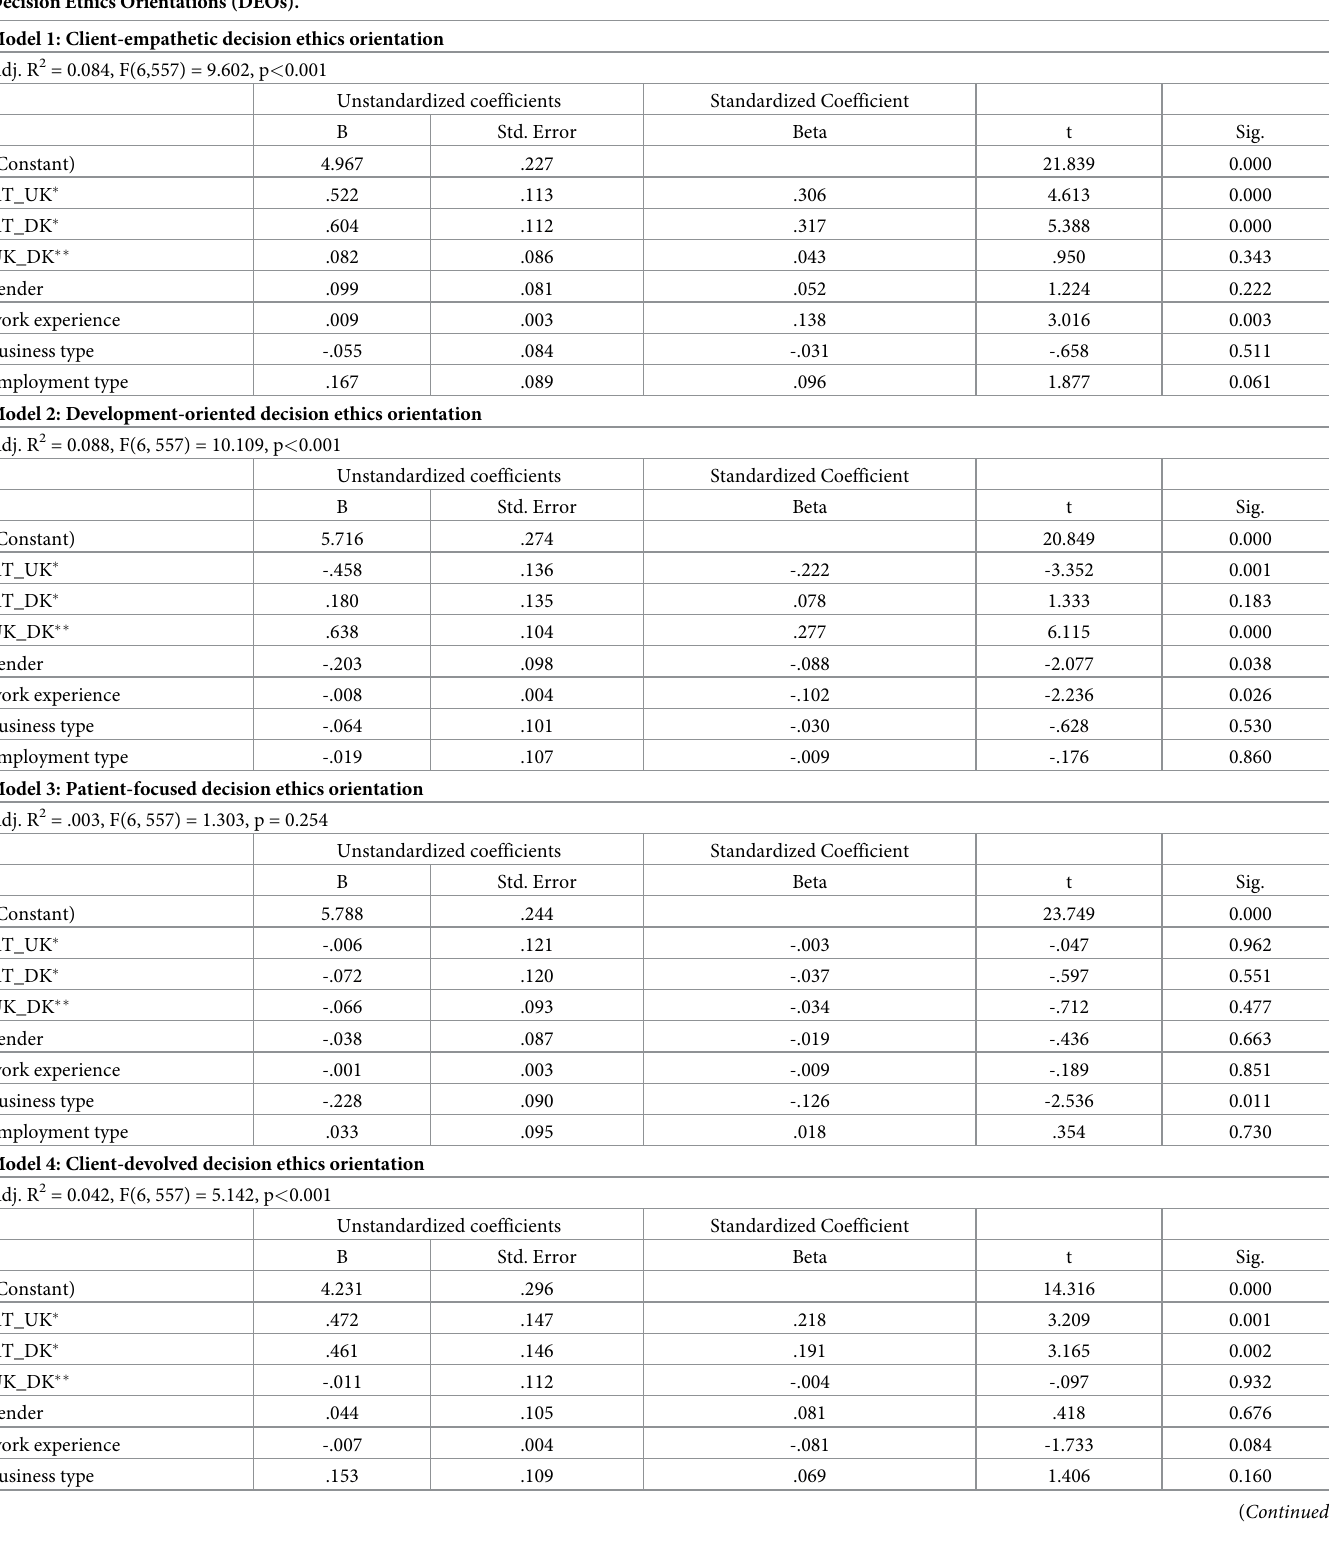
Table 5. Multivariate regression analyses of predictors (including socio-demographic (with work experience), practice-specific factors, and country) of the four Decision Ethics Orientations (DEOs). Model 1: Client-empathetic decision ethics orientation